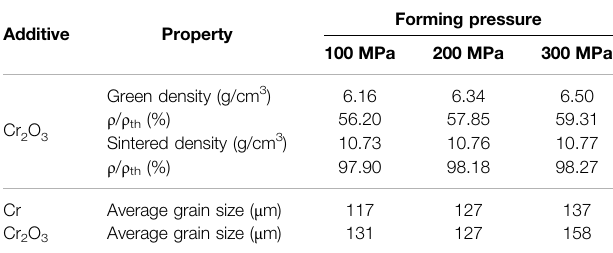
TABLE 5 | The average grain size of doped UO 2 pellets with different powder TABLE 6 | Green density, sintered density and average grain size of UO 2 pellets pretreatments. under different forming pressures. ρ and ρ th are the density measured by the geometric method and the theoretical density, Powder pre-treatment Property Additive